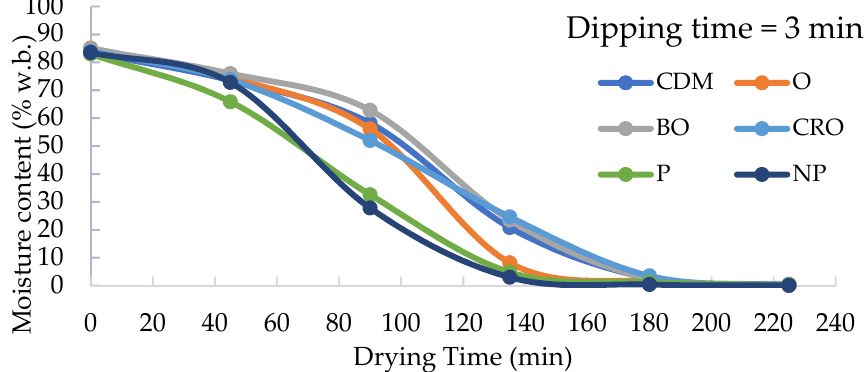
Figure 4. Effect of 3 min dipping time on drying time of different pre-treatments (tangerine ( Citrus deliciosa Mediterranean) (CDM); orange (O); bitter orange (BO); tangerine ( Citrus reticulate Owari ) (CRO); pomegranate (P); non-pre-treatment (NP)). The fastest dipping pre-treatment process for reaching the final moisture content of 10% (w.b.) was pomegranate juice application. Considering the drying times of the dipping times as 1, 3 and 5 min with pomegranate juice pre-treatment, it resulted in 135, 123 and 121 min,